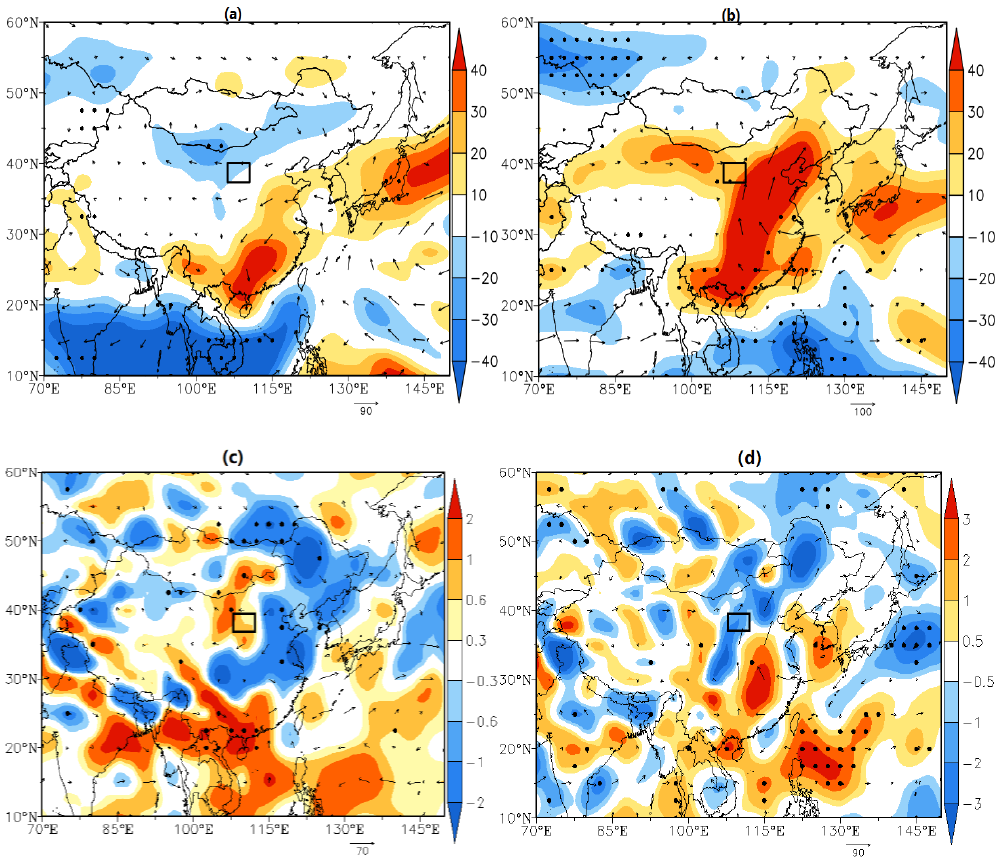
Figure 9. Integrated water vapor flux (Unit: kg·(m·s) −1 ) ( a , b ) and water vapor flux divergence anomalies (Unit: 10 −5 kg·(m 2 ·s) −1 ) ( c , d ) in the summer of typical drought years ( a , c ) and flood years ( b , d ). The black points indicate the area passing the 0.05 significance test. The rectangular area indicates the study area.